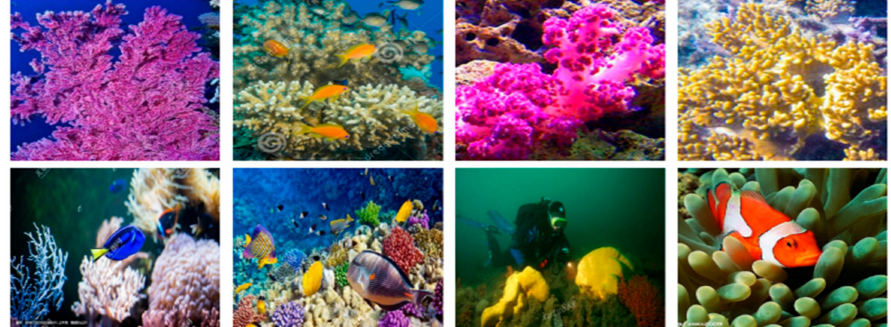
Figure A8. Coral images with complex background obtained by the web crawler.